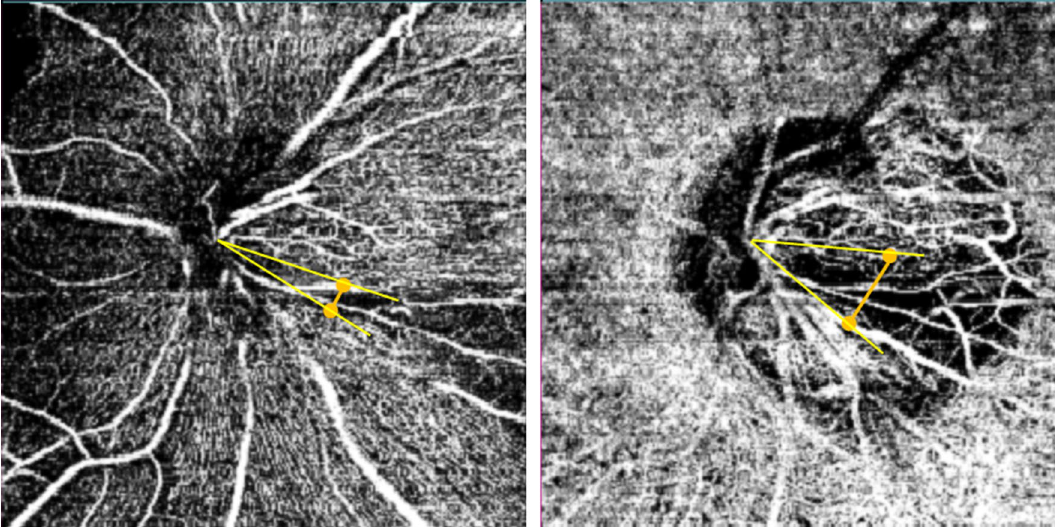
Figure 5. Method for measuring the width of vessel density defect in the image of optical Coherence Tomography Angiography. At the edge of the optic disc, the point where the border of the localized vessel defect (VD) met with the edge was identified. Subsequently, each straight line was drawn to the center of the optic disc. The angle which was generated between two lines was measured, and was defined as the width of the